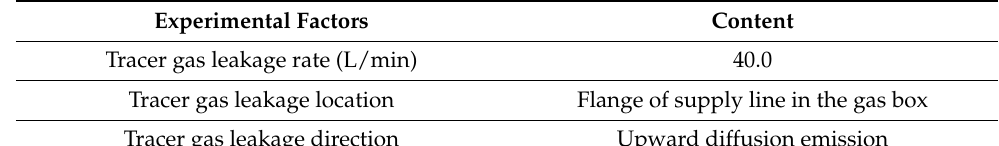
Table 2. Parameters used in the tracer gas